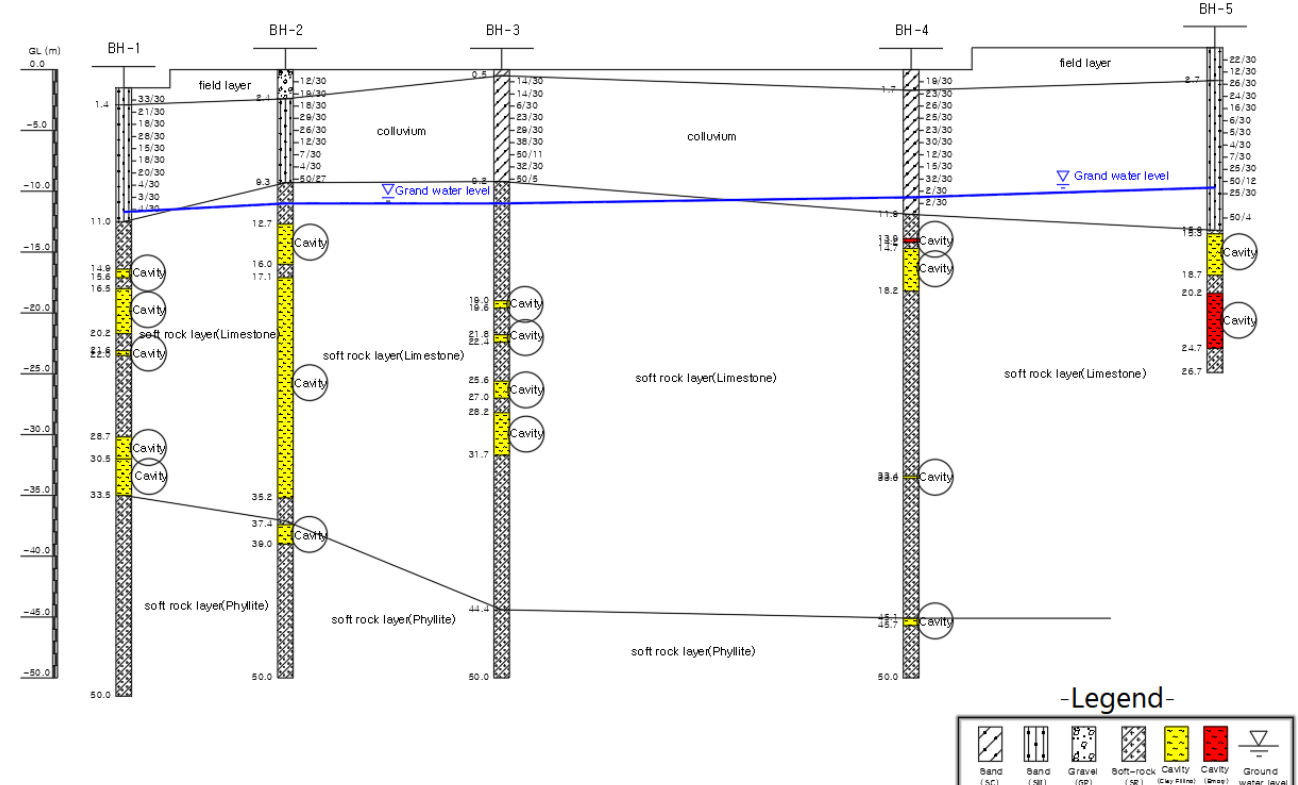
Figure 20. Developed geological section from 2018 drilling investigations (2019).